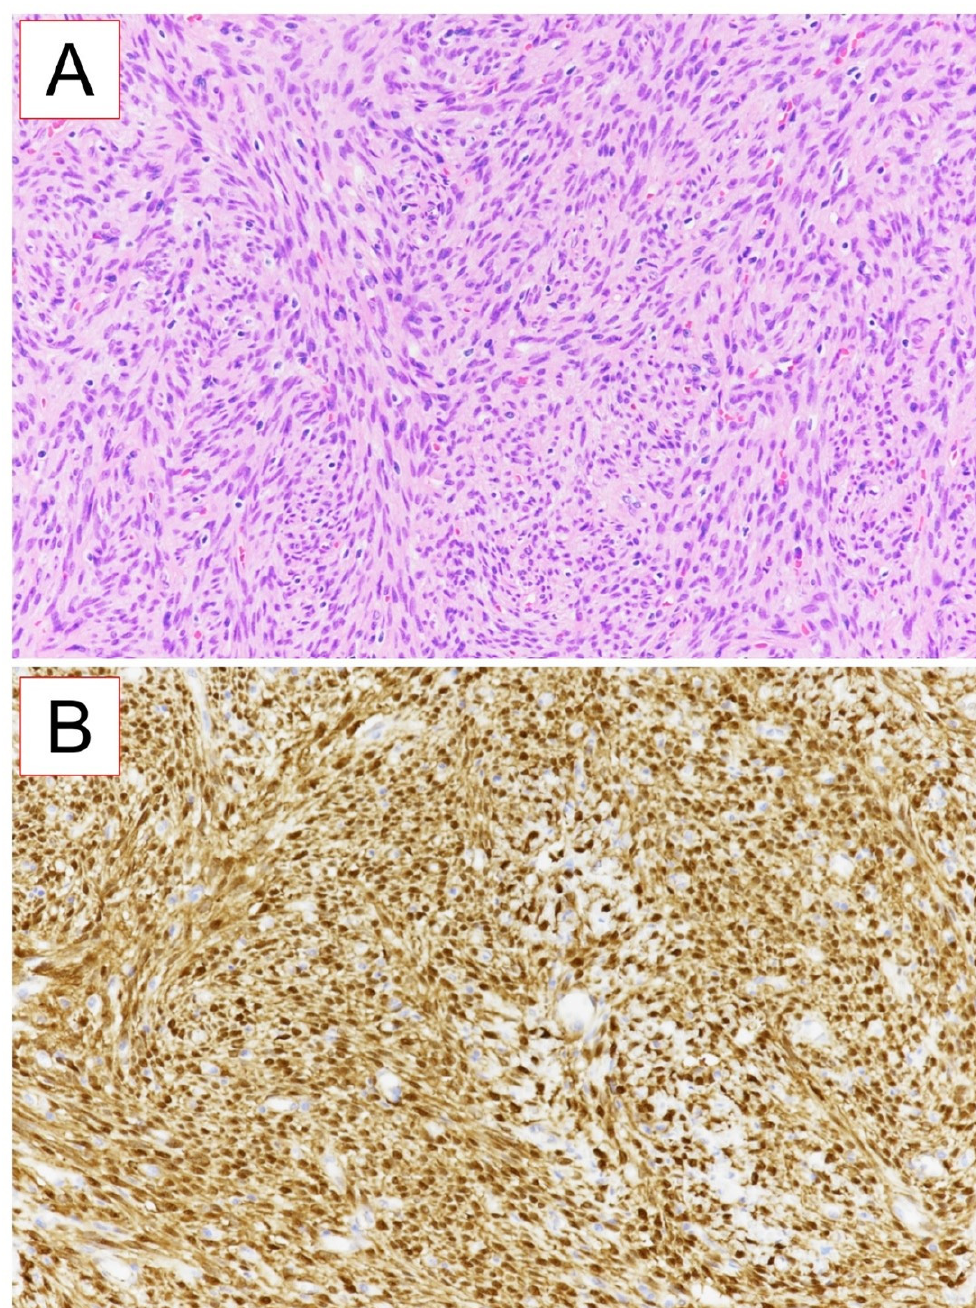
Figure 5. Histological examination of glomangiopericytoma: HE coloration ( A ) and β -catenin immunostaining ( B ) (×200 magnification) shows richly vascularized proliferation consisting of uniform spindle cells with hyperchromatic nuclei and poorly delineated eosinophilic cytoplasm, forming clusters and storiform structures.